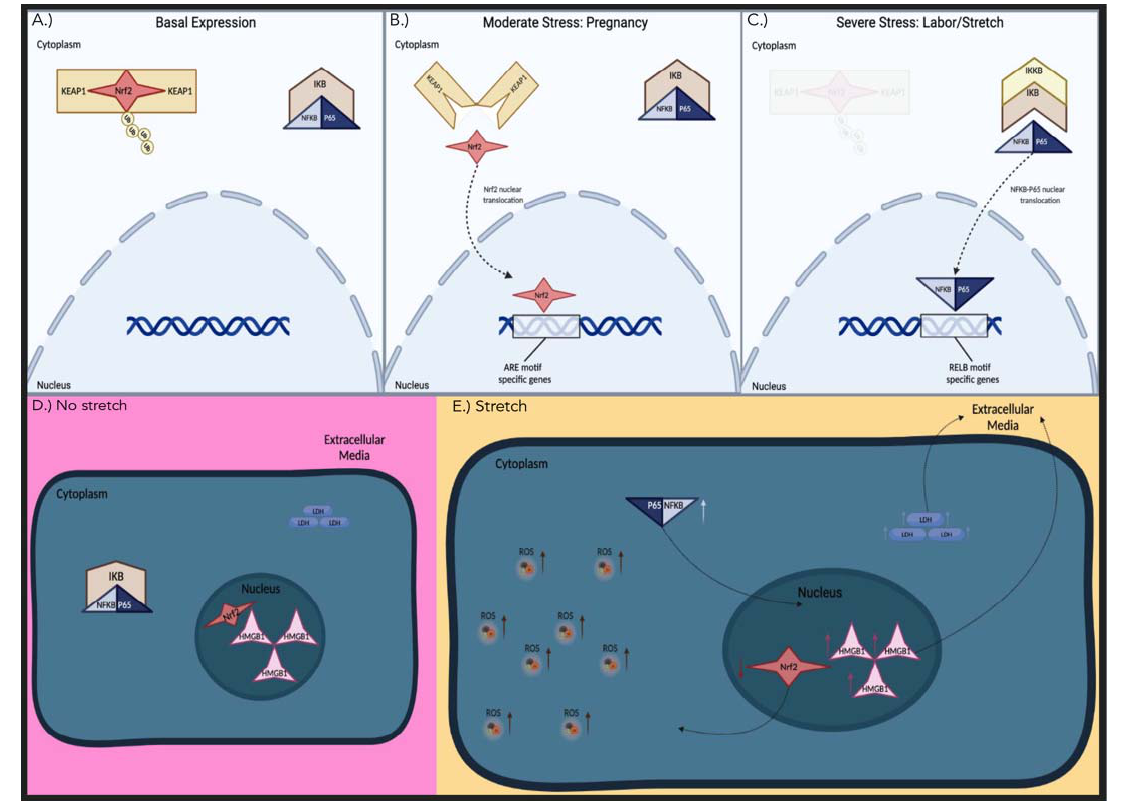
Figure 5. Summary of Nrf2 and NF-kB activity depending on the level of cell stress. (Top A – C ) Activation of the transcription factors Nrf2 and NF-kB depending on the level of cellular stress. ( A ) Illustrates normal physiological conditions with no significant stress present. Ubiquitinated Nrf2 is bound to KEAP1, and NF-kB-p65 is bound to IkB, which inhibits their translocation into the nucleus. ( B ) The effects of moderate stressors such as the third trimester of pregnancy. Nrf2 dissociates from KEAP1, which allows for the nuclear translocation and binding to the ARE motif-specific genes. NF-kB-p65 remains bound to IkB in the cytoplasm. ( C ) Instances of severe stress equitable to labor and cell stretching. The elevated stress causes the eviction of the KEAP1-Nrf2 complex and activation of IKKB, which inhibits the inhibition of IkB, thus activating NF-kB-p65 and causing translocation of the dimer into the nucleus and binding to the RELB motif-specific genes. (Bottom D , E ) Human amnion epithelial cells, ( D ) not stretched, ( E ) stretched 20%. Stretched cells had increased cytoplasmic ROS, increased secretion of HMGB1, and increased LDH activity. They also showed a decrease in total and nuclear Nrf2 and an increase in nuclear NF-kB-p65. Image created with Biorender (https://biorender.com, accessed on 9 May 2022).